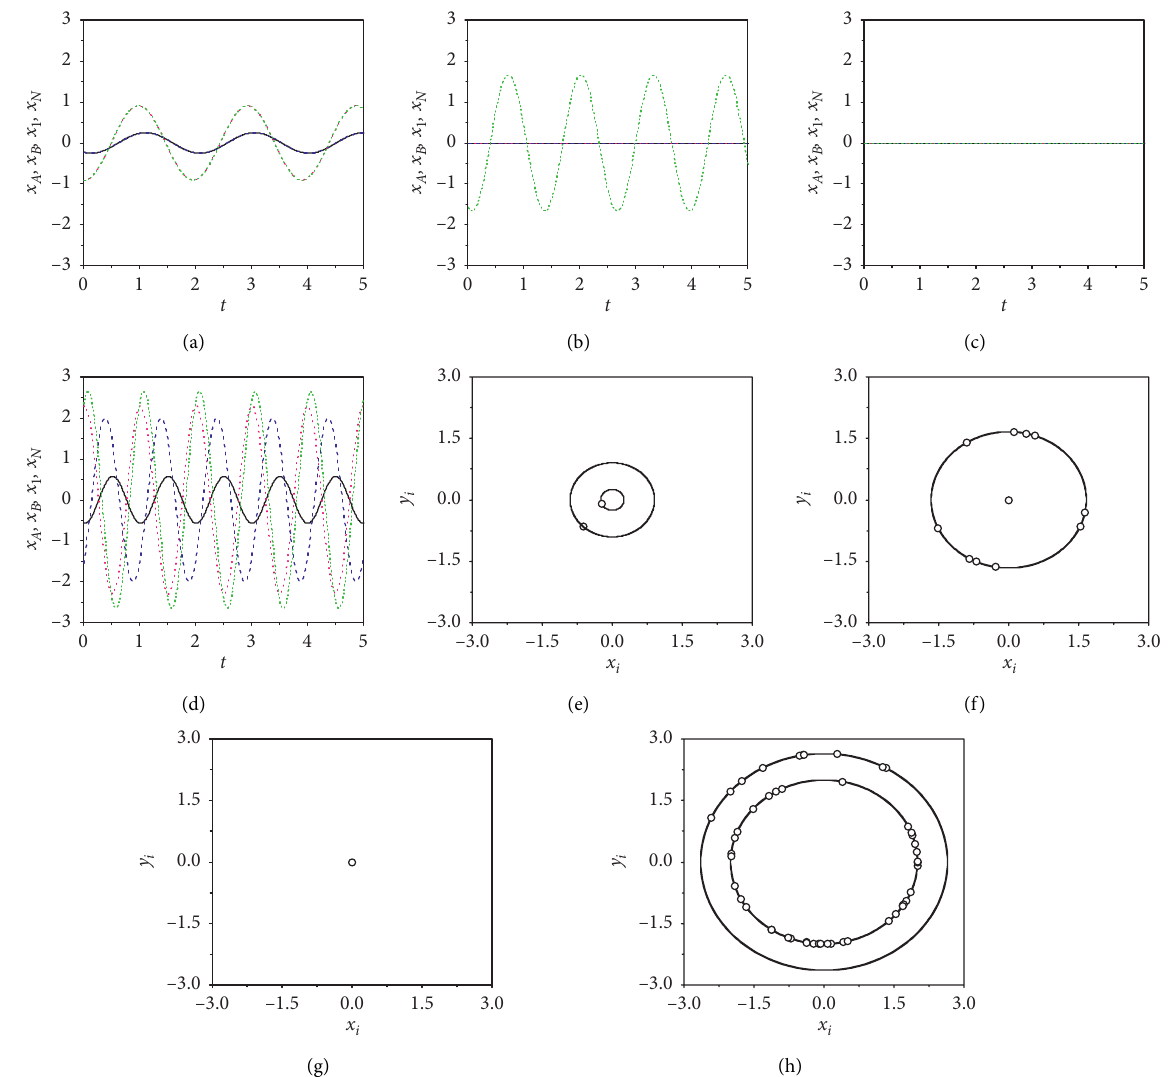
Figure 3: (a)–(d) Time series for x and x N ( t ) (green dash-dot-dot line. (e)–(h) Phase diagrams for ( x i ,y i ) . κ � 2 and δ � 0 . 1 (a, e), κ � 2 and δ � 0 . 4 (b, f), κ � 6 and δ � 0 . 1 (c, g), and κ � 6 and δ � 0 . 4 (d, h). p � 0 .